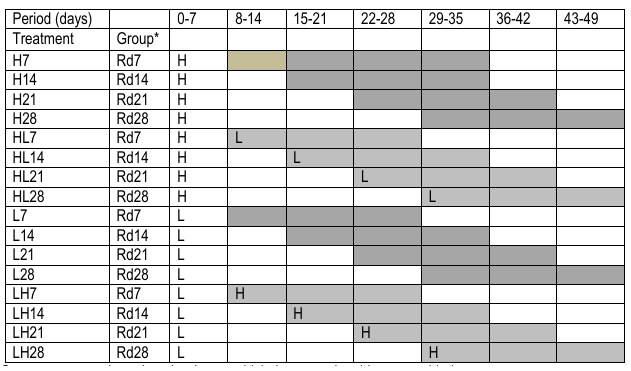
Tab. 2: Treatments and plant growth period, where H represents high C/N ratio residue and L low C/N residues. Shaded areas indicate plant growth period.